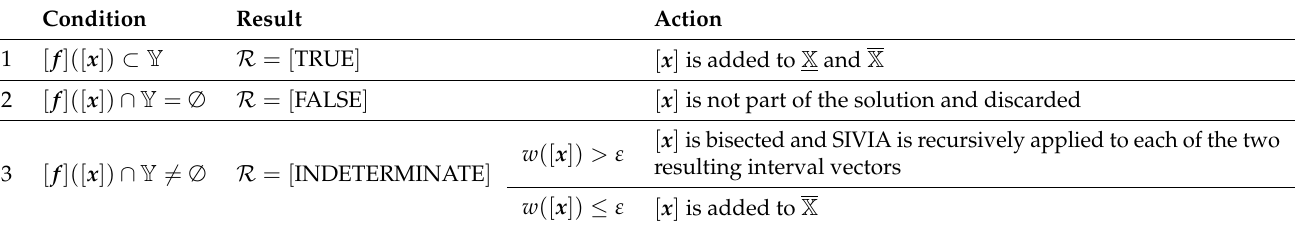
Table 1. Procedure of the SIVIA